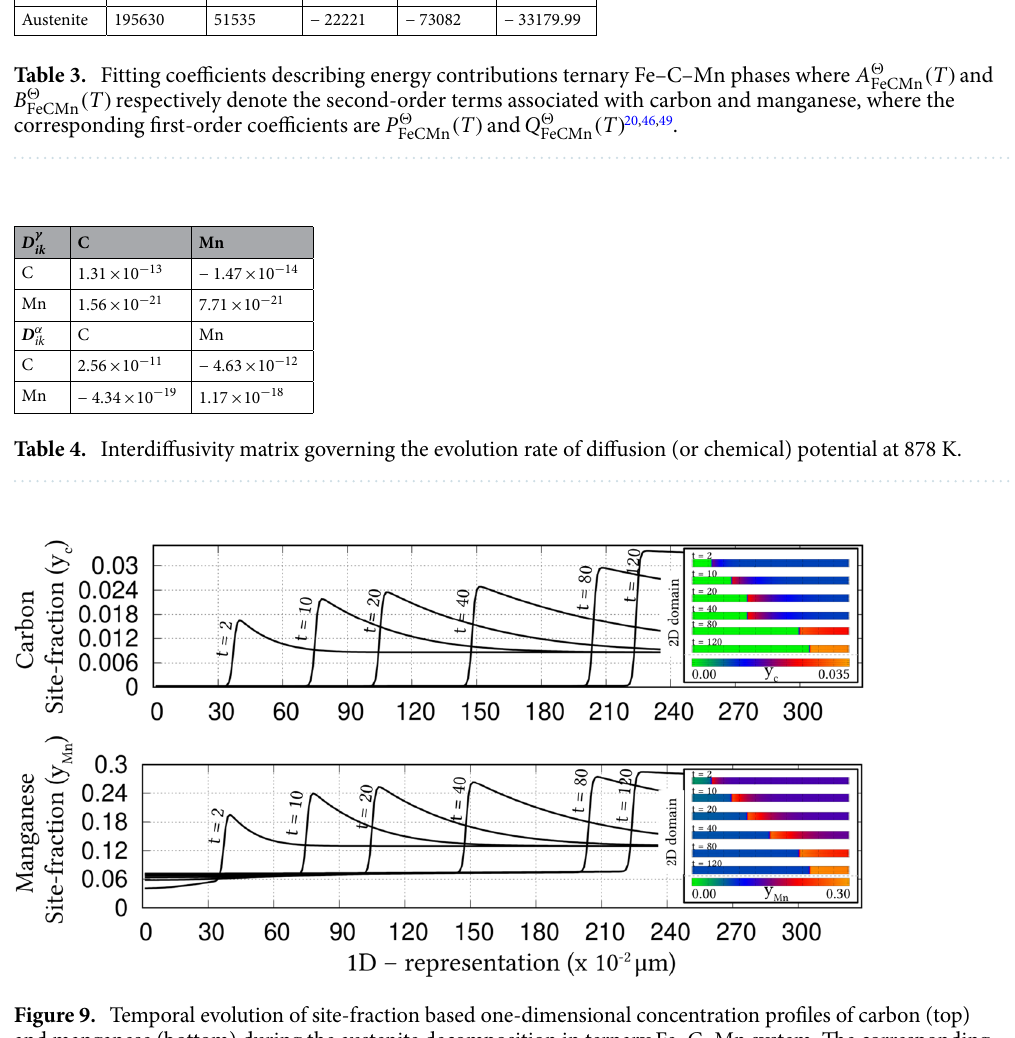
Figure 9. Temporal evolution of site-fraction based one-dimensional concentration profiles of carbon (top) and manganese (bottom) during the austenite decomposition in ternary Fe–C–Mn system. The corresponding distribution of the alloy elements over the entire domain is shown as